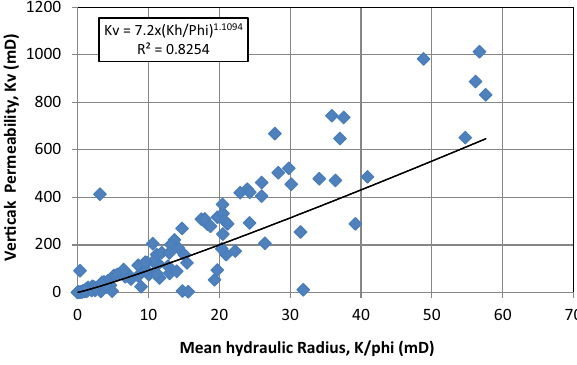
Kv = 7.2x(Kh/Phi) 1.1094 R² = 0.8254